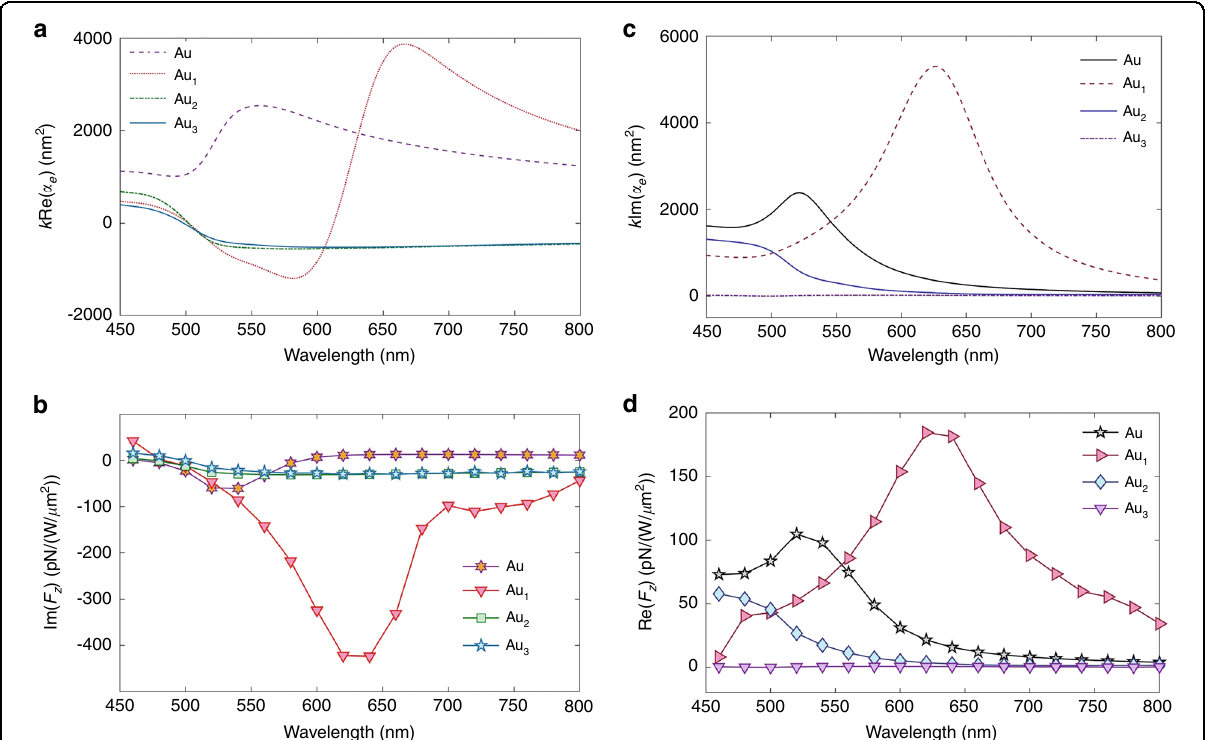
Fig. 6 Linearly polarized propagating plane wave incident on a sphere with radius a = 50 nm of gold and of three hypothetical materials. a Real part of polarizability of a sphere of radius a = 50 nm, from Mie theory of: Au and three hypothetical materials denoted as Au 1 , Au 2 and Au 3 , whose refractive index real parts are equal to those of Au, but their imaginary parts are arti fi cially set to: A half of Au imaginary part (Au 1 ), the same as , on each of these spheres illuminated by a linearly polarized plane wave with the real part (Au 2 ), and zero (Au 3 ). b Numerical results of ILF, F I z amplitude E 0 = 1. c Imaginary part of polarizability of the four spheres. d Numerical calculation of RLF, < F z >, on each of these spheres under the same incident wave as in